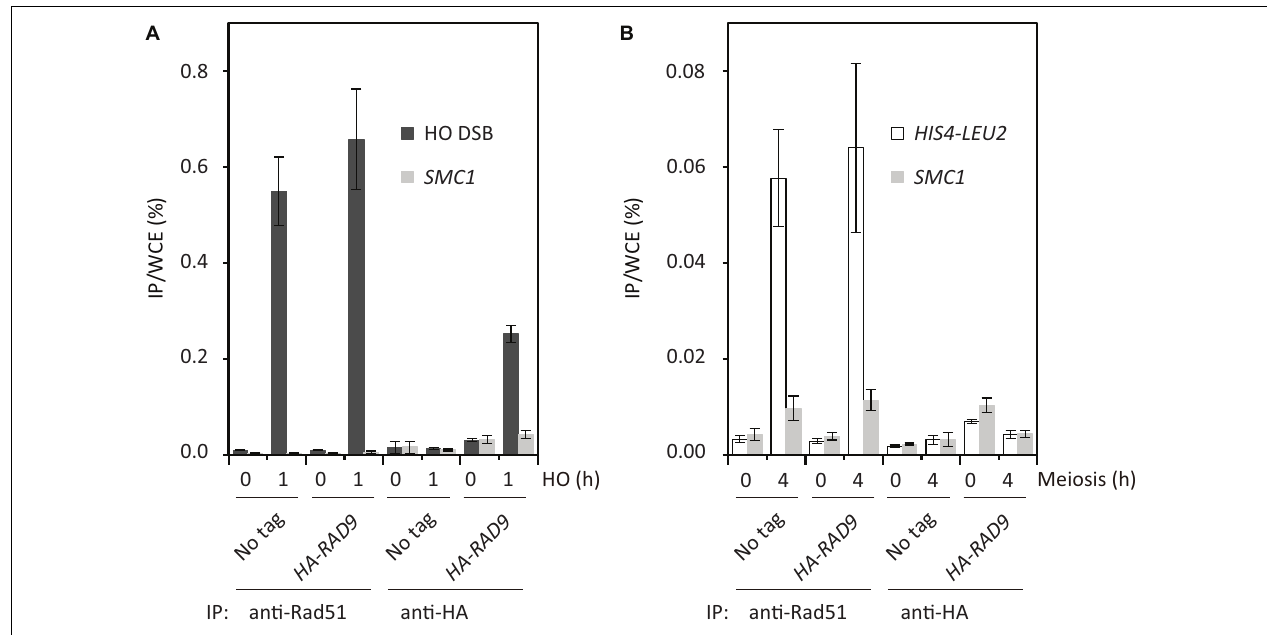
FIGURE 4 | Rad9 is insensitive to meiotic DSBs. Rad9 binding to chromatin adjacent to mitotic HO-induced DSBs (A) and to meiotic programmed DSBs at the HIS4-LEU2 locus (B) was tested by ChIP. Formaldehyde-fixed chromatin extracts were prepared at 0 and 1 h after HO DSB induction in G2/M-arrested cells, and at 0 and 4 h after meiotic induction, followed by anti-HA and anti-Rad51 ChIP. Anti-HA- or anti-Rad51-bound DNAs were quantified by real-time PCR. Error bars represent standard deviations obtained from 3 independent cultures. The non-tagged wild-type and HA-RAD9 strains examined were USY99 and USY100 in (A) and NKY1551 and USY2035 in (B) ,